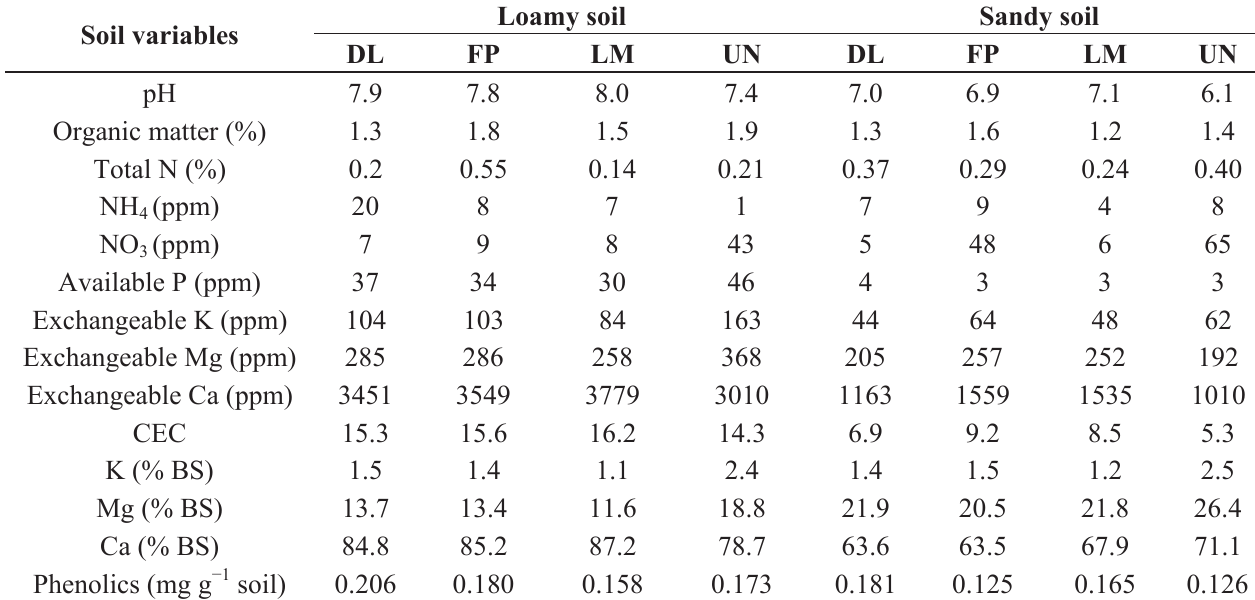
Table 1. Effects of soil conditioning by three different plant species in two soil types on soil properties. Several plants of each species were first grown in containers of each soil type for six months to condition soil, while an unconditioned soil for each soil type was maintained in the same manner. Conditioning treatments: DL = Diervilla lonicera